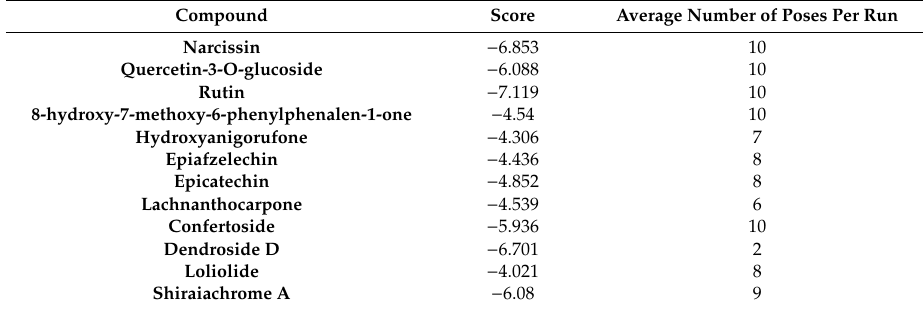
Table 2. The lowest energy ranked results of target compounds HAase binding